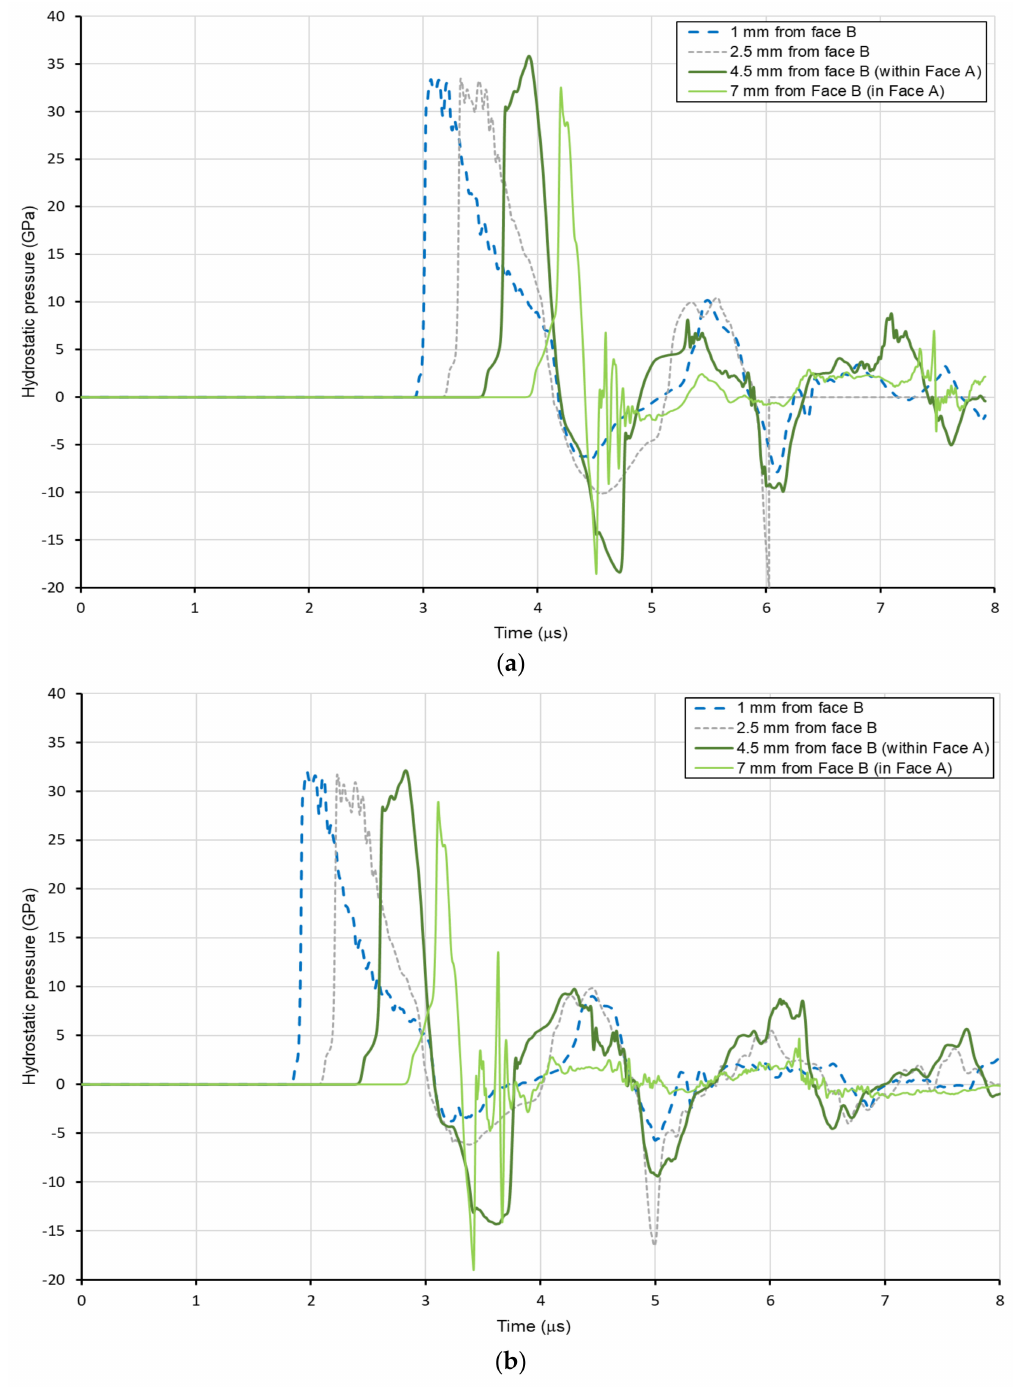
Figure 10. Simulated hydrostatic pressure development in an 8 mm ball bearing subjected to ( a ) 11 g charge, 18 mm diameter, ( b ) 20.37 g charge, 30 mm